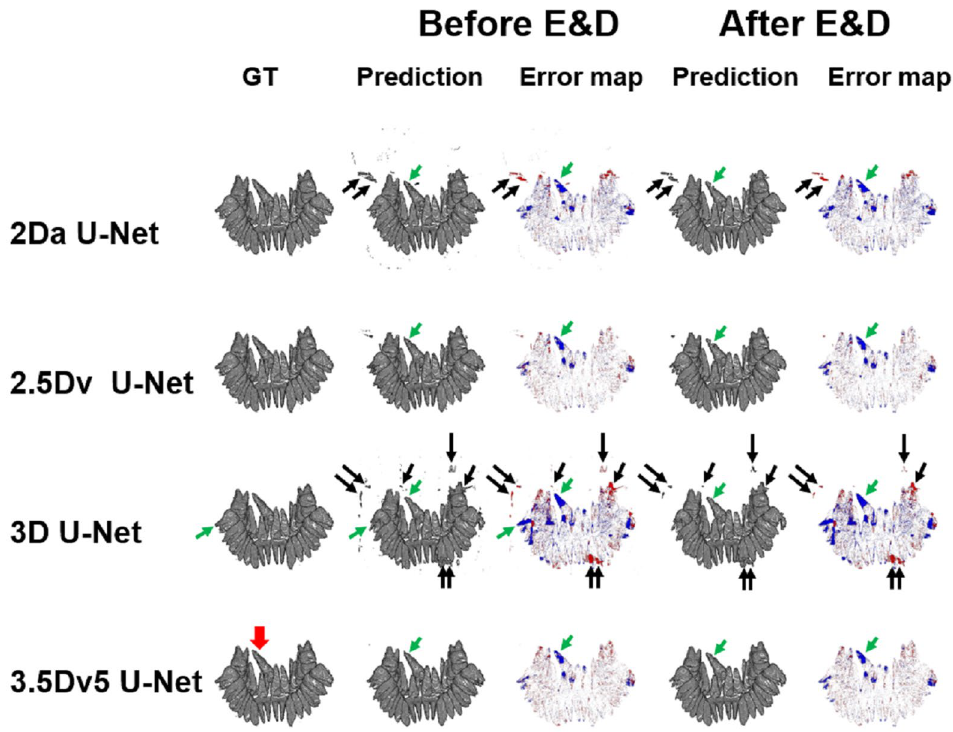
Figure 11. Illustration of ground truth, prediction, and error map in a patient with impacted right maxillary second incisor (red arrow) before and after E&D in 2Da U-Net, 2.5Dv U-Net, 3D U-Net, and 3.5Dv5 U-Net. The 2Da U-Net and 3D U-Net show different false positive results and false negative results, which are eliminated by either majority voting or E&D. Some larger false positive results (black arrows) in the 2Da U-Net and 3D U-Net, which are not eliminated by E&D, are completely eliminated by the 3.5Dv5 U-Net. On the other hand, the false negative results (green arrows) appearing in the 2Da U-Net and the 3D U-Net remain similar on 2.5Dv U-Net and 3.5Dv5 U-Net before and after E&D.